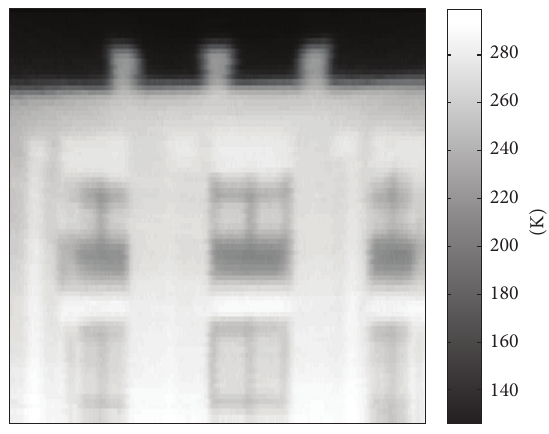
Figure 15: The corrected passive image of the